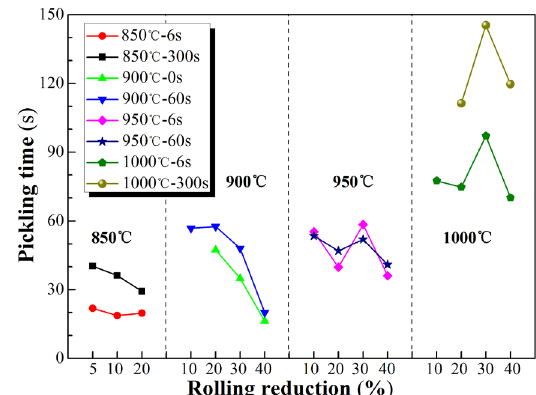
Figure 6. The pickling time of steel strip samples in different rolling